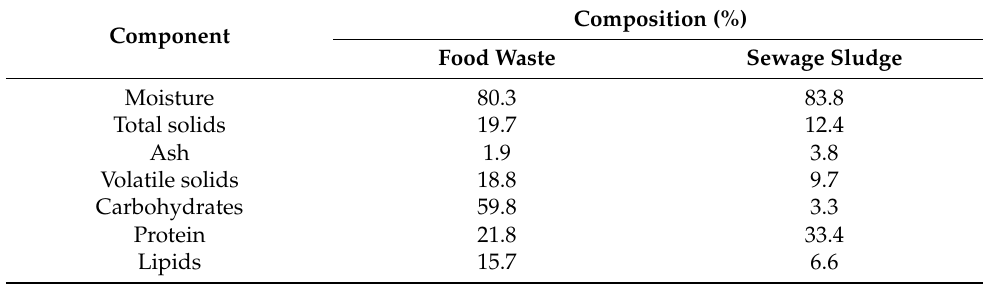
Table 1. Kitchen food waste and sewage sludge composition